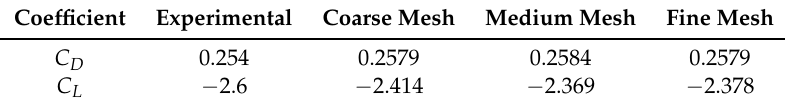
Table 3. Drag and lift coefficients for all three levels of mesh compared to the Zerihan’s results. Coefficient